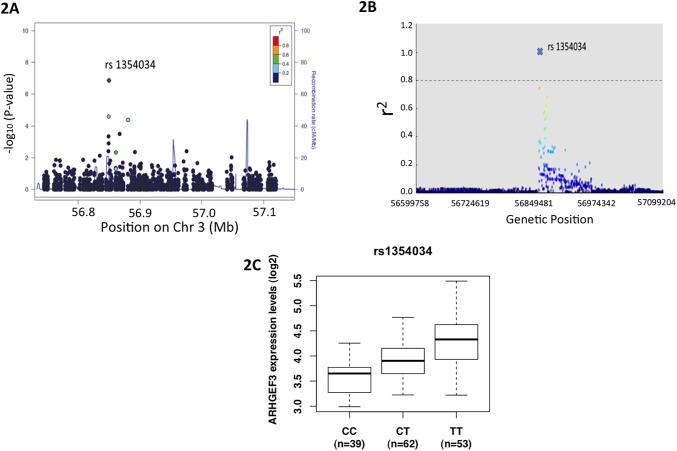
rs1354034 is the leading SNP and an eQTL for ARHGEF3 expression.(A) Visual summary of the statistical evidence for variant-phenotype association at the locus of rs1354034 from data generated by the TEMPLE targeted sequencing study. It shows the variant specific P-values from Fisher’s exact tests against null hypotheses that genotype frequencies are the same in the high and low platelet count samples. The color of each point represents the r2 between the corresponding variant and rs1354034, estimated from the TEMPLE genotypes. The continuous line indicates the local recombination rate estimated from HapMap data. (The tool used to generate the plot is available at doi:10.1093/bioinformatics/btq41.) (B) Shown is rs 1354034 (blue X) and its LD structure in +/- 250 kb window. There is no SNP in linkage disequilibrium (threshold r2 >0.8) found 250k bp up- or downstream of the rs1354034 locus (data from 1000 Genome Project), suggesting rs1354034 is the leading SNP of ARHGEF3. (C) A strong association of the rs1354034 genotype with ARHGEF3 mRNA levels (p = 1.37x10-15, ordinary linear regression). This association stayed significant even after accounting for subject age, gender and race (p = 2.39 x 10−11, multiple linear regression). Primary data for 5C in online S1 Table.